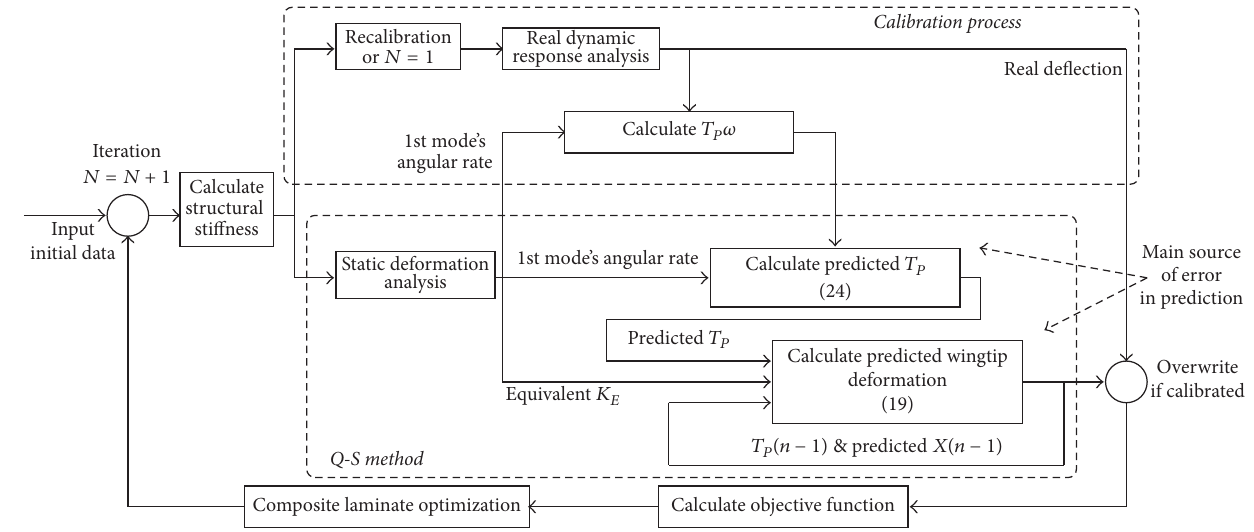
Figure 2: The flowchart of the Q-S method in structure optimization procedure.